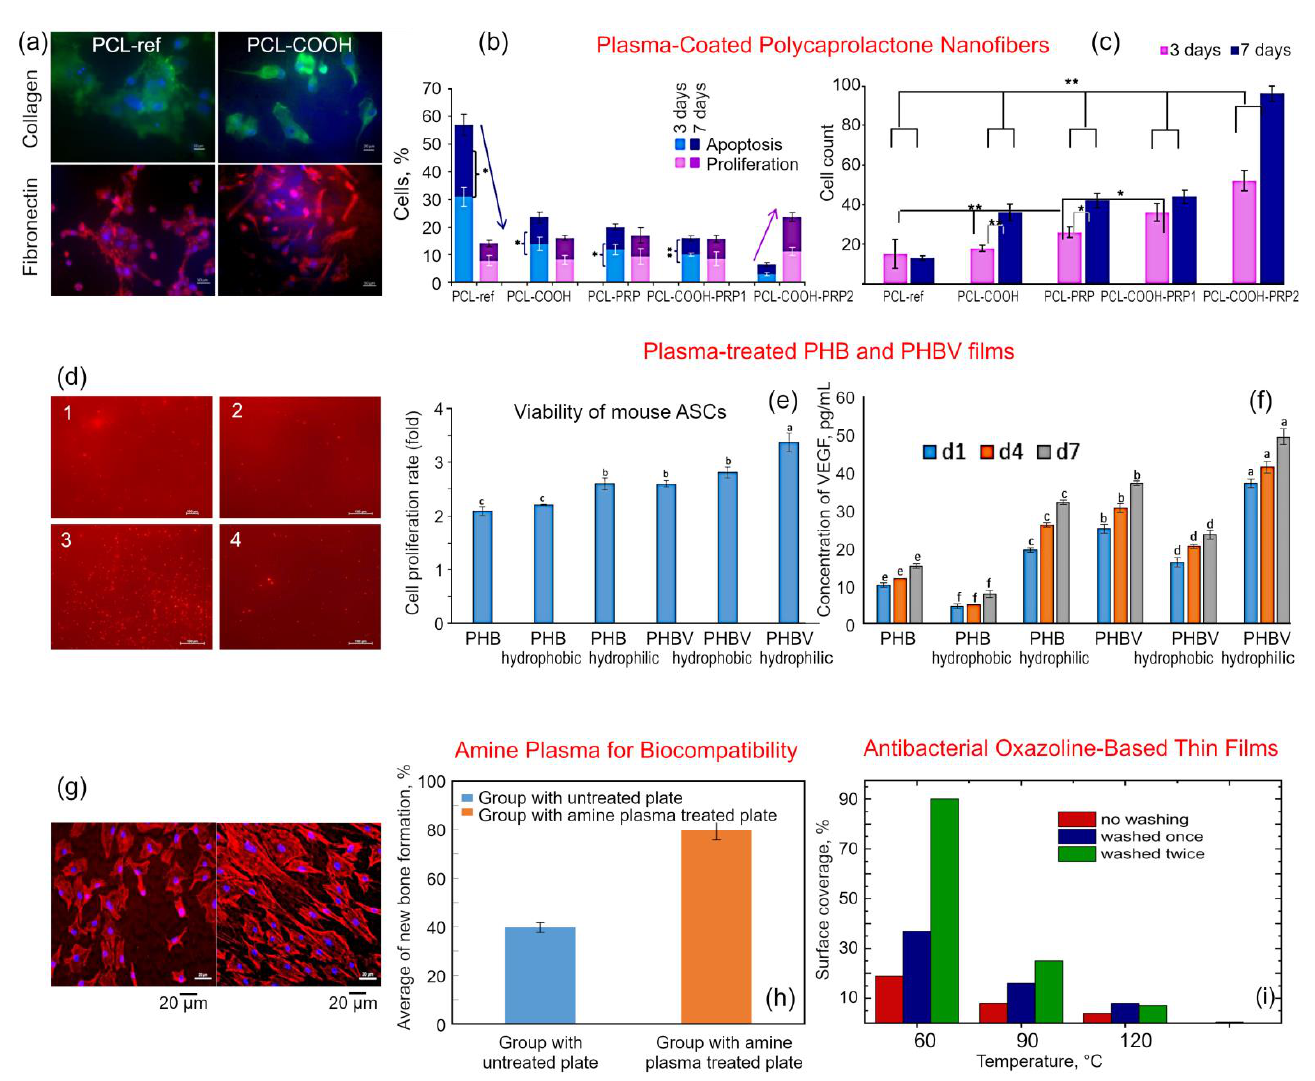
Figure 5. ( a ) Fibronectin (FN) and collagen secretion by the fibroblasts seeded on PCL-ref and PCL-COOH. Cells were stained by antibody Alexa Fluor 594 (orange) to collagen (magnification 40×) and Alexa Fluor 488 to FN (magnification 20×). ( b , c ) The influence of scaffold surface on ( a ) cell proliferation and apoptosis, and ( b ) cell count for three and seven days of cultivation. The arrows indicate the relationship of the level of cell apoptosis and cell proliferation. Reproduced from Miroshnichenko et al. (2019) [41] under conditions of the CC BY license. ( d ) Cell adhesion of in vitro cultured mouse ASCs onto various plasma-treated films. ( e ) Cell proliferation rate of in vitro cultured mouse ASCs on PHB, PHB hydrophobic, PHB hydrophilic, PHBV, PHBV hydrophobic, and PHBV hydrophilic surfaces. ( f ) Concentrations of VEGF secreted from in vitro cultured mouse ASCs on PHB and PHBV films over a 7-day period. Reproduced from Chang et al. (2018) [42] under conditions of the CC BY license. ( g ) Morphologies of cells on the surfaces of plates: untreated titanium plate (left) and titanium plate treated with amine plasma (right). Nuclei color is blue. ( h ) Comparison of the average percentage of new bone formation for each specimen in the animal experiments. Reproduced from Jeong et al. (2019) [43] under conditions of the CC BY license. ( i ) Bacteria S. epidermidis surface coverage area (percent) formed on POx films deposited at different substrate temperatures. Reproduced from Stahel et al. (2019). [44] under conditions of the CC BY license.